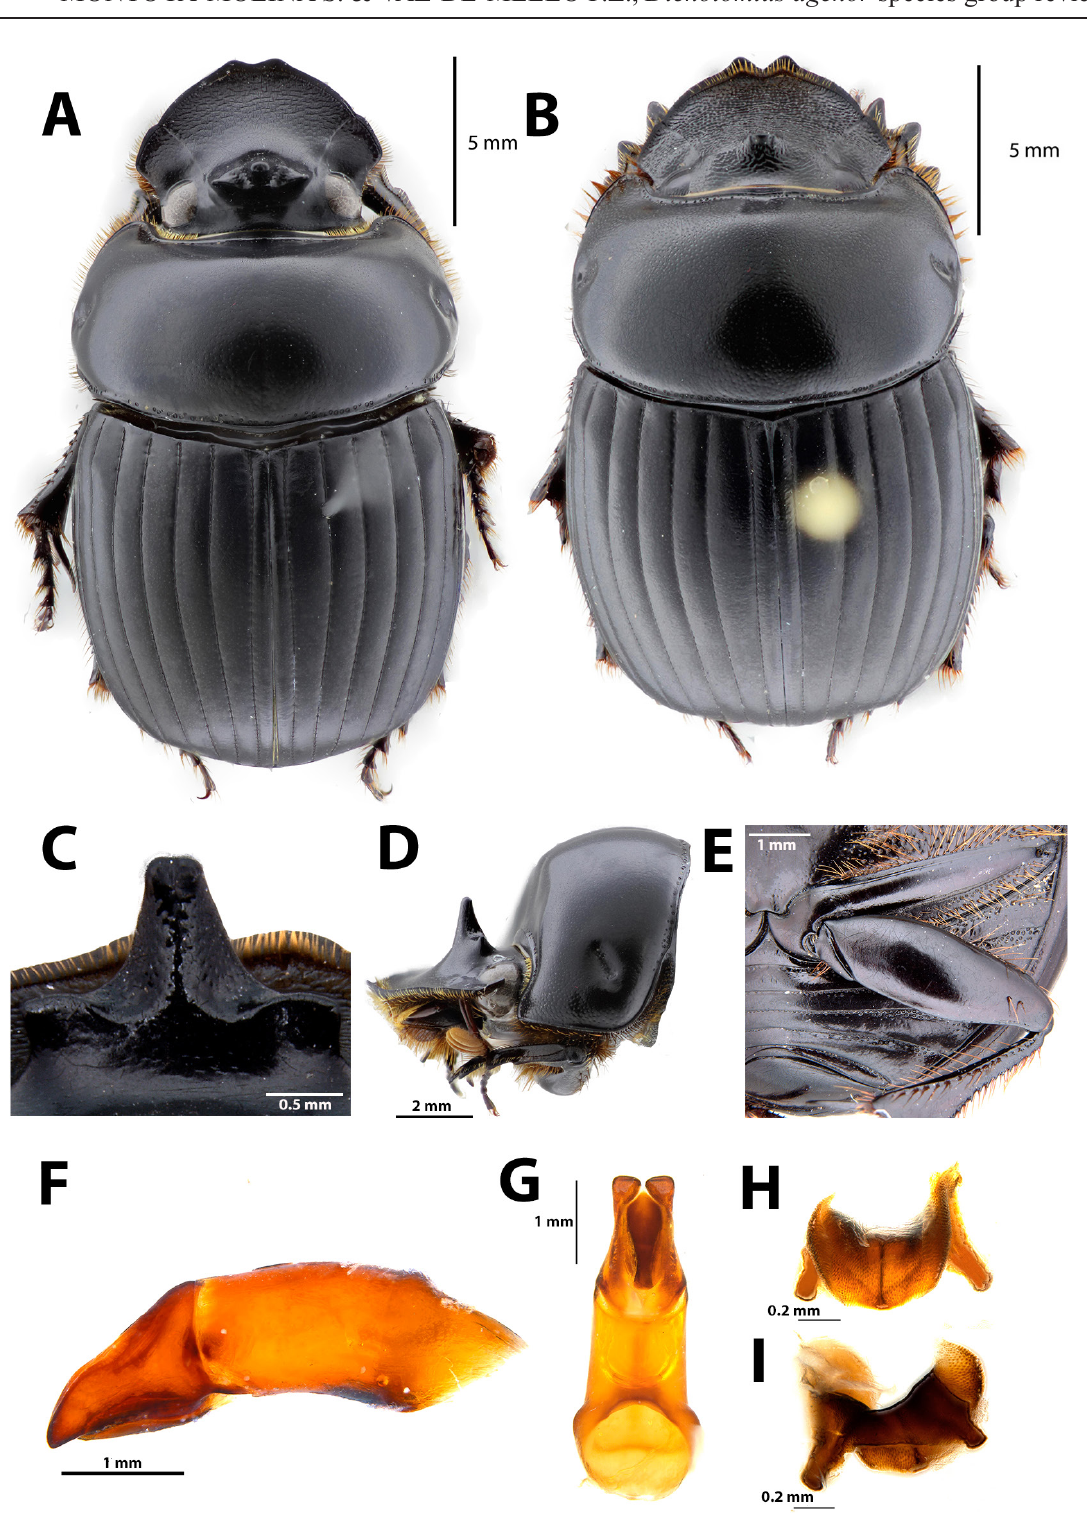
Fig. 3. Dichotomius agenor (Harold, 1869). A–B . Dorsal habitus. A . ♂. B . ♀. C . Posterior view of the cephalic carina, concavity between the central and the lateral tubercles, apically emarginate. D . Lateral view of the pronotum, anterior declivity truncate. E . Ventral view of the metacoxa, displaying two rows of punctures on the posterior margin. F . Lateral view of the aedeagus. G . Ventral view of the aedeagus. H–I . Lamella